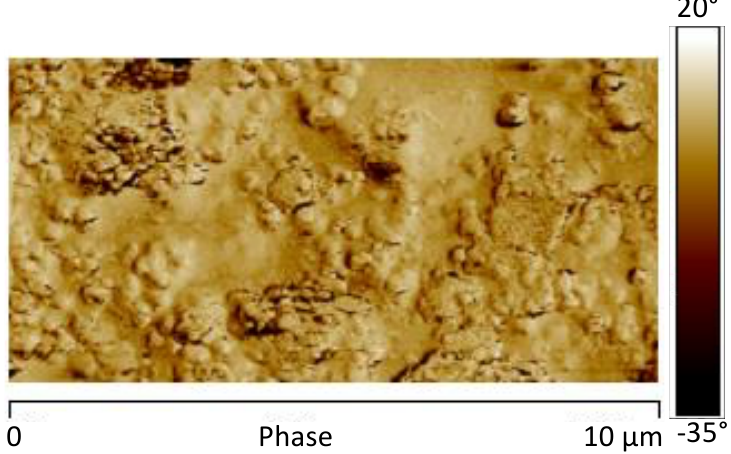
Figure 18. AFM phase map image of the sample 1GNPs (550).